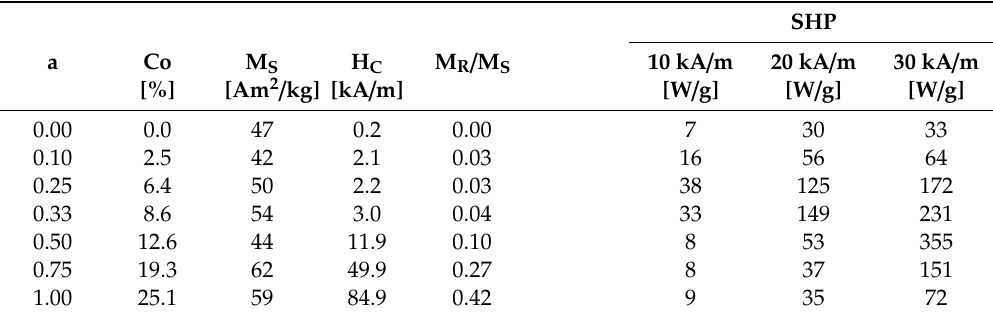
Table 2. Overview on the magnetic properties of the prepared particles with varying Co content: the saturation magnetization (M S ), the coercivity (H C ), the relative remanence (M R /M S ) as well as the specific heating power (SHP) for different magnetic fields strengths during hyperthermia experiments at 235 kHz on particles immobilized in gelatine.